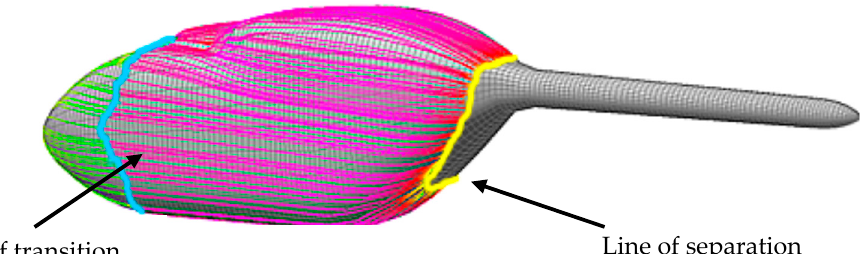
Figure 7. Streamlines on the surface of conventional fuselage model including transition forecast. The streamlines end on the separation line.